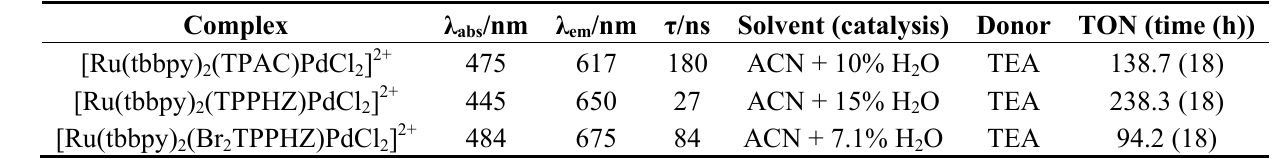
Table 13 . Photophysical and catalytic data for representative ruthenium II complexes. Lifetimes are measured in aerated acetonitrile